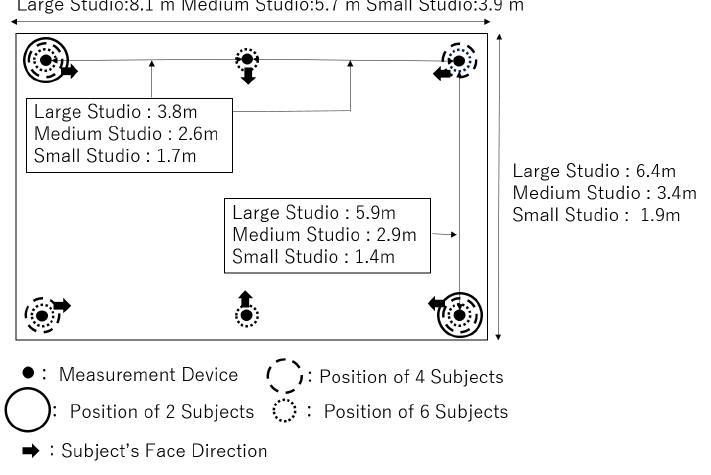
Figure 11. Position of subjects and measurement devices in three